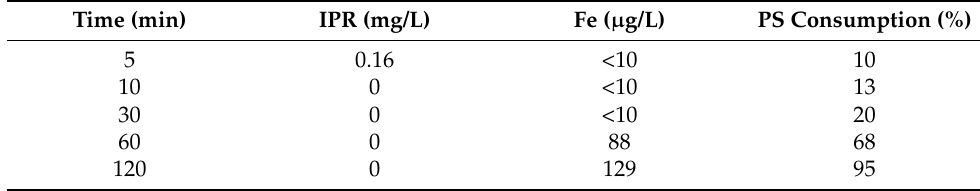
Table 1. IPR abatement, Fe release and PS consumption observed during ZVI/PS treatment of IPR.